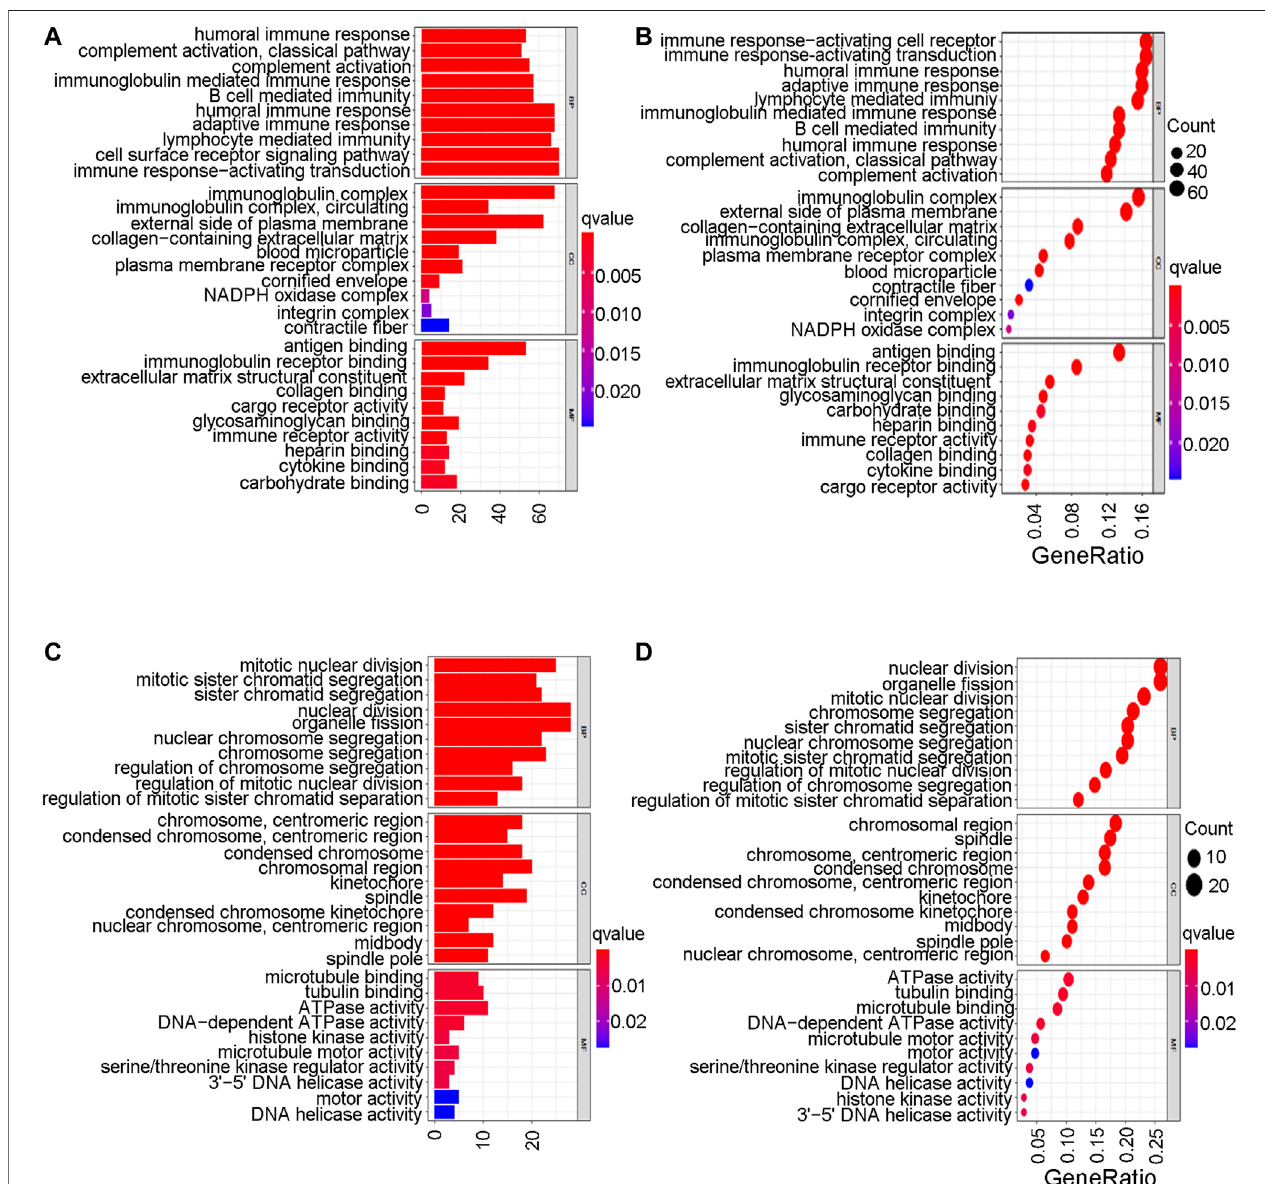
FIGURE10| Goenrichmentanalysis. (A) TheGOenrichmentanalysisbybarplotinTCGAcohort. (B) TheGOenrichmentanalysisbybubblechartinTCGAcohort. (C) The GO enrichment analysis by barplot in GEO cohort. (D) The GO enrichment analysis by bubble chart in GEO cohort.